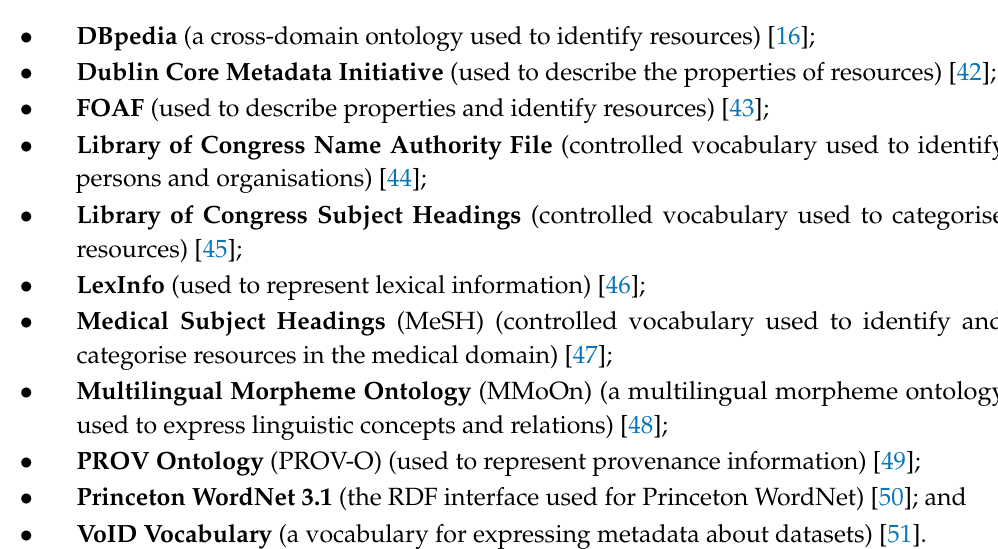
2 6 1 3 4 5 7 Inter- Separation & Linguistic Morphological Multi- Ontological Linked operability Independence Information Decomposition linguality Representation